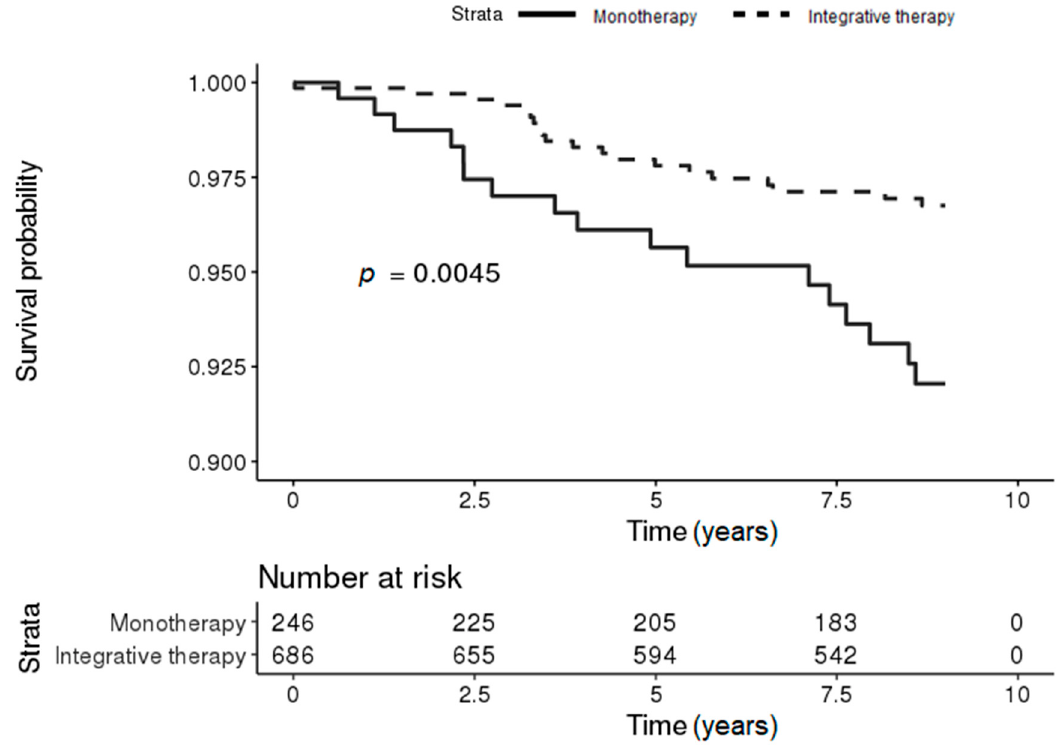
Figure 3. Kaplan–Meier survival curves for the incidence of PD in patients with IBD according to KM treatment in the mild Charlson Comorbidity Index (CCI) group (conventional [monotherapy] vs. integrated [conventional and Korean medicine]).